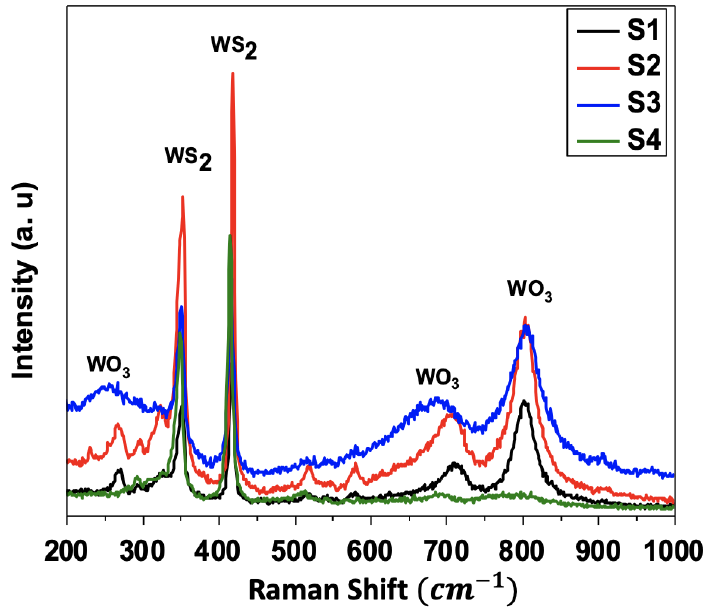
Figure 4. Raman spectra for the four prepared WS 2 samples. Note the absence of WO 3 vibration modes at 286 𝑐𝑚 −1 , 666 𝑐𝑚 −1 , and 820 𝑐𝑚 −1 in sample S4, which highlights the high purity of WS 2 .